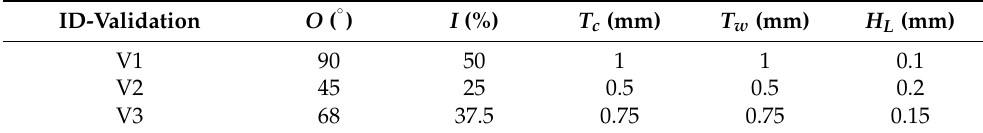
Table 8. Combination of factors used in the validation set.